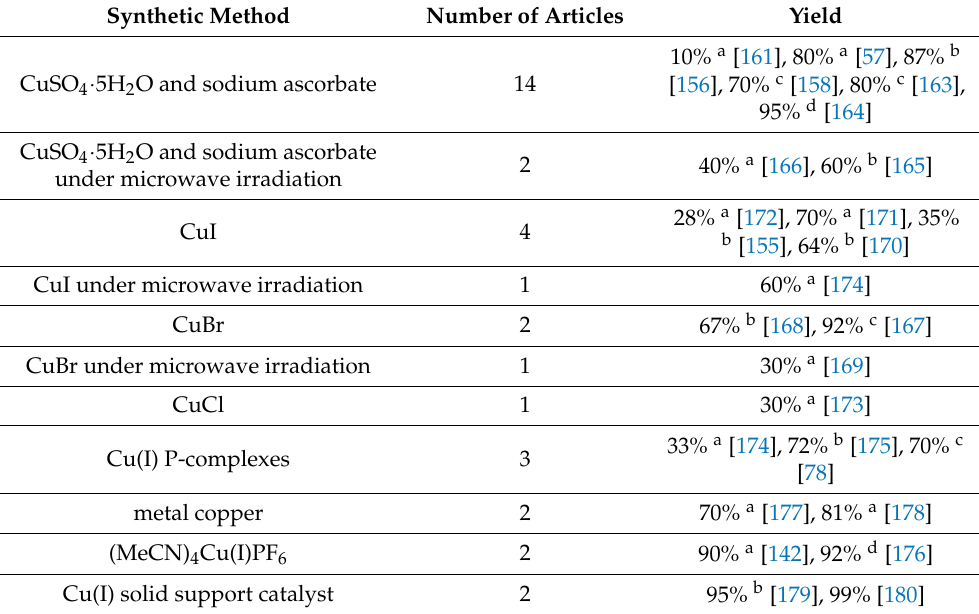
Table 7. Preparation of 1,4-substituted triazoles of